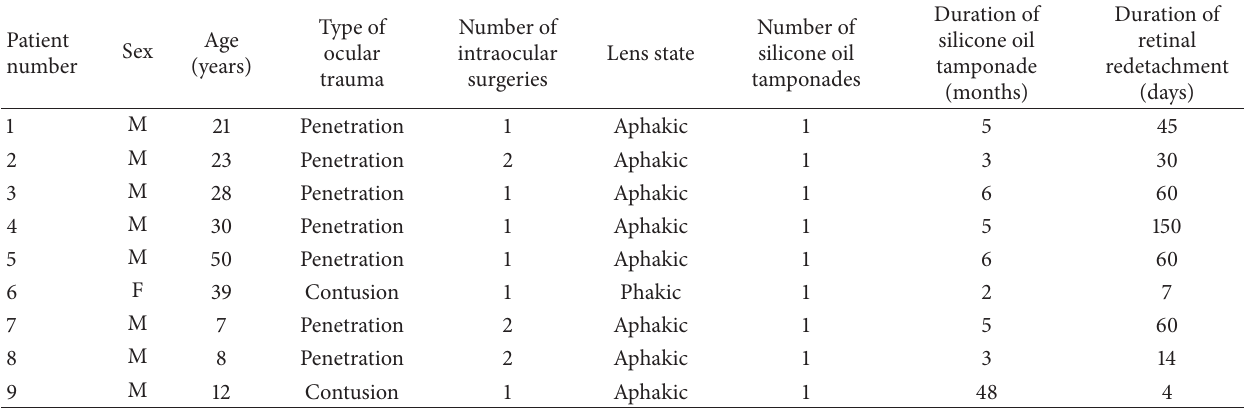
Table 1: Demographic and ocular characteristics at baseline